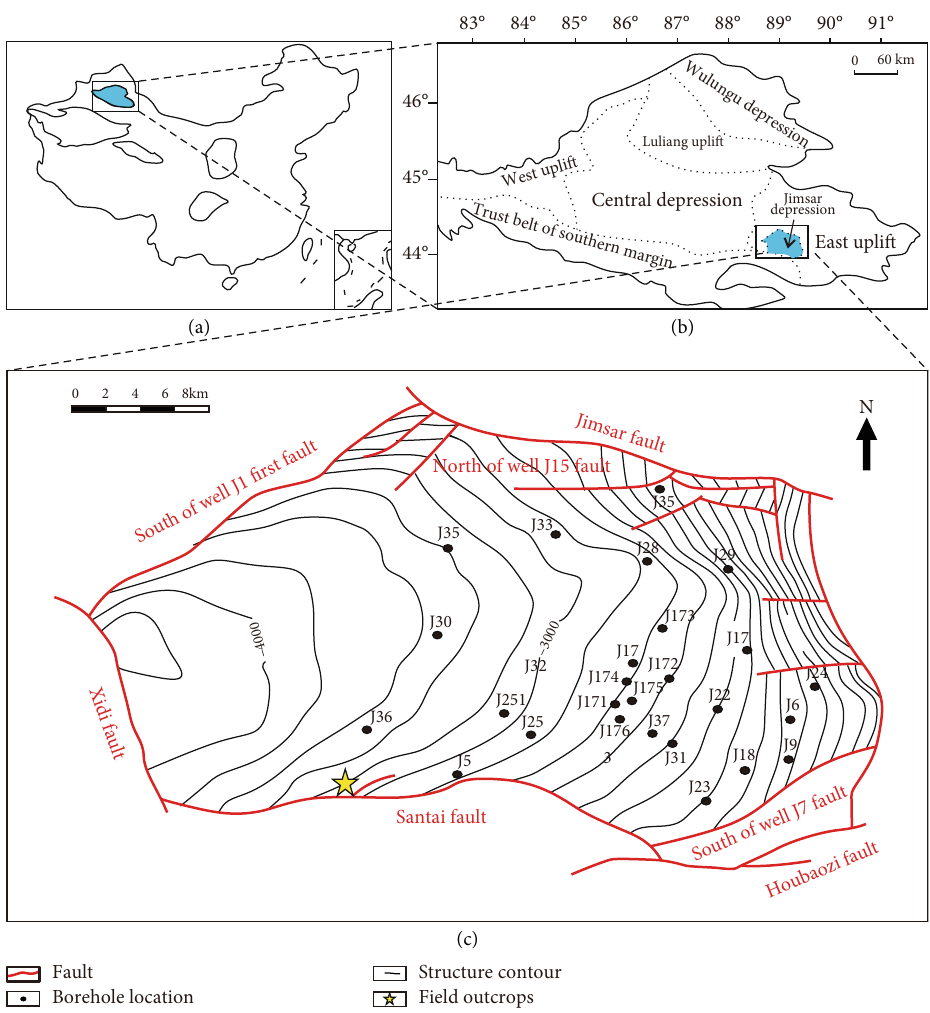
Figure 1: The Tectonic setting map of Jimsar sag